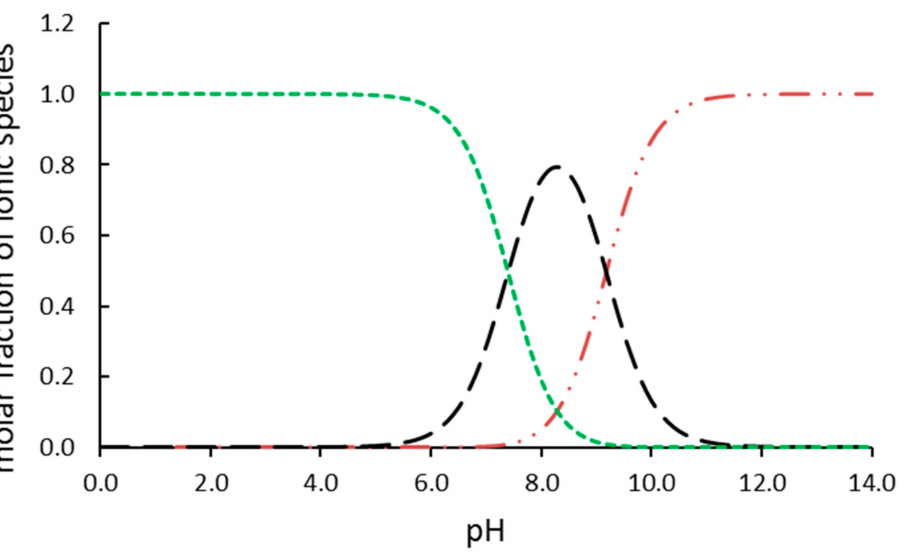
Figure 2. Ionic species of TBBPA in solution: TBBPA (green), TBBPA – (black), and TBBPA 2– (red). The ozone in water (pH > 7) reacts with a hydroxyl anion yielding hydroxyl radicals, thus the · OH radical dominates in the reaction system 1 as an oxidizing